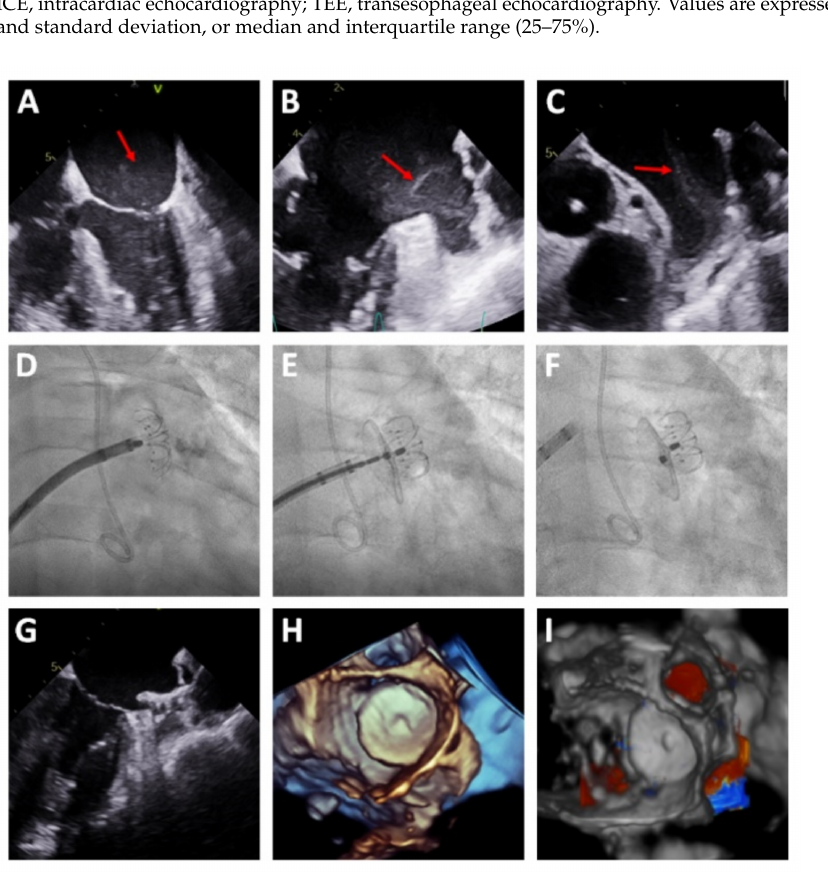
Figure 3. LAAC with early thrombosis. ( A ) TEE suggestive of “smoke” in the left atrium (red arrow). ( B , C ) Smoke/early thrombosis in the LAA (red arrow). ( D – F ) LAAC guided exclusively by TEE. ( G ) TEE verification of the correct implantation of the device. ( H , I ) 3D TEE showing the LAAC device without a peridevice